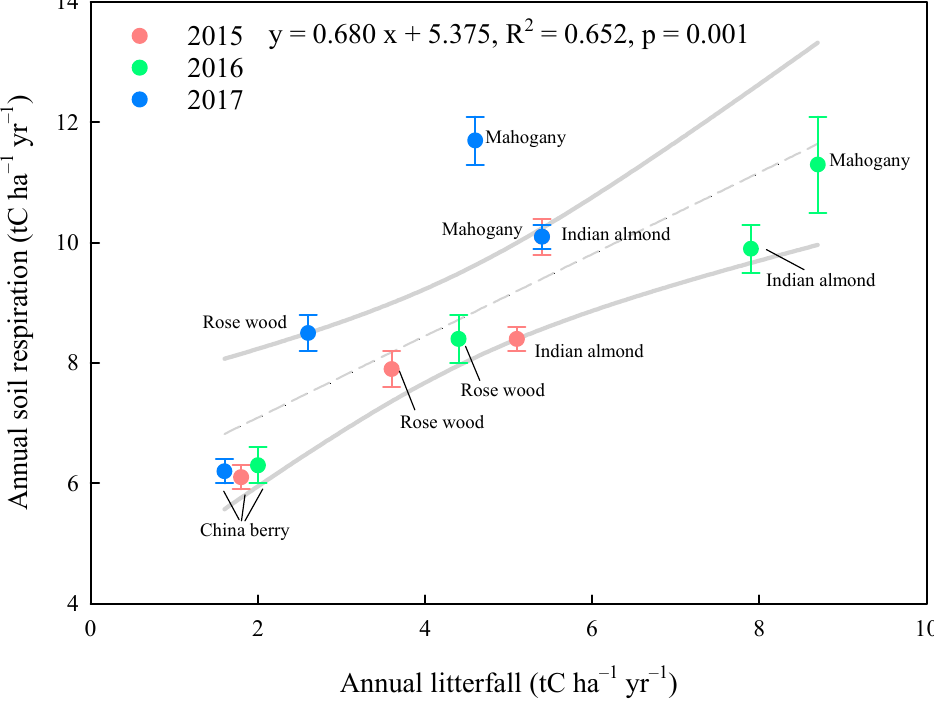
Figure 6. Relationships between annual litterfall and annual soil respiration. Dashed curves represent a significant relationship between annual litterfall and annual Rs, including all measurement data from 2015 to 2017. Pairs of gray curves show the 95% prediction intervals based on regression analysis. Values are presented as the mean ± standard errors, n = 4.